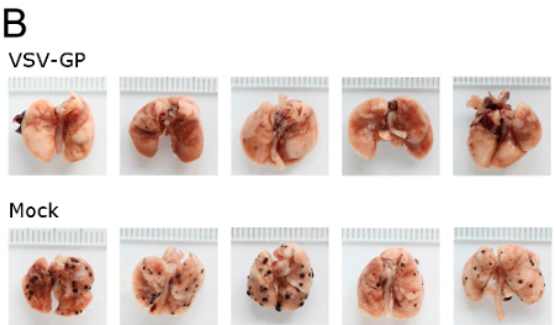
Figure 7. VSV-GP reduced the number of metastasis in a syngeneic mouse melanoma model. Murine melanoma lung metastases were established in C57BL/6 mice by the intravenous injection of 1 × 10 6 B16-OVA cells. Mice were treated intravenously (i.v.) with 5 × 10 8 PFU VSV-GP on days 2, 4, 6, 8, and 10, or were left untreated. On day 14, mice were sacrificed, and lungs were examined visually for metastases. The mean number of metastases for untreated animals was set to 100% ( A ). The graph shows data from two independent experiments, n = 8. The means and values for individual animals are depicted. *** p < 0.0001 (Unpaired, two-tailed t -test). Exemplary pictures from lungs from the second experiment are shown ( B ).